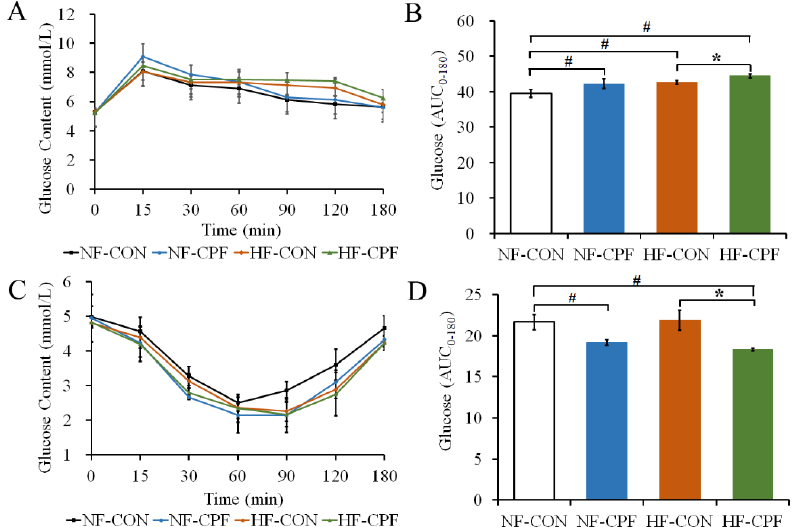
Figure 2. Effects of CPF on rat glucose tolerance and insulin tolerance in response to NF diet and HF diet. ( A ) The blood glucose content of rats after different points were gavaged with glucose. ( B ) Total glucose content of the area under the glucose curve during the whole testing period in ( A ). ( C ) The blood glucose content of rats after insulin injection at different points. ( D ) Total glucose content of the area under the glucose curve during the whole testing period in ( C ). CPF—Chlorpyrifos. NF-CON—fed a normal-fat diet and vehicle. NF-CPF—fed a normal-fat diet and chlorpyrifos. HF-